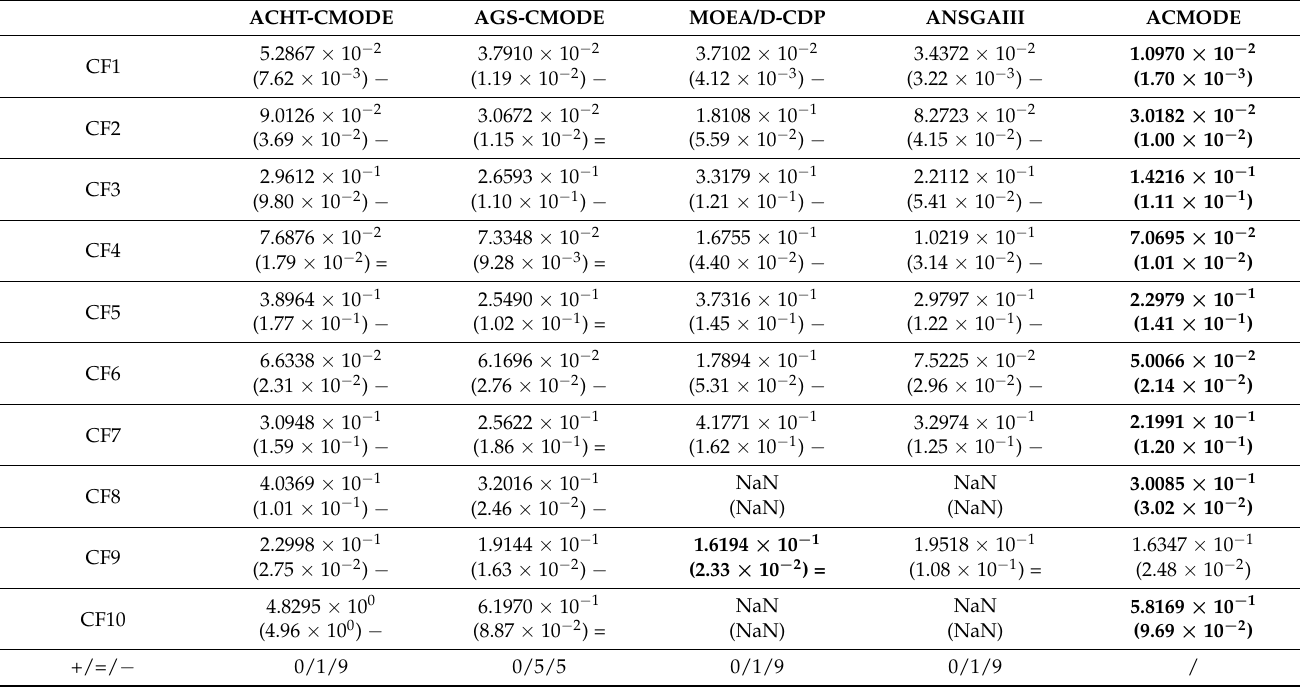
Table 2. IGD results of all comparison algorithms on CF test suite.